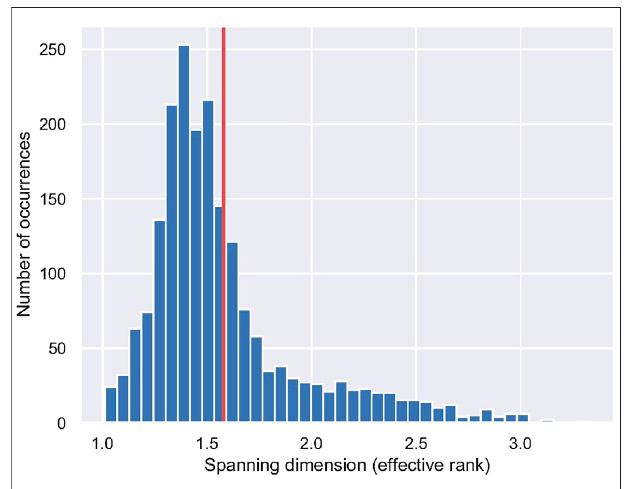
FIGURE 1 | Estimated spanning distribution for an MLP with (A) ReLU activation functions, and (B) sigmoid activation